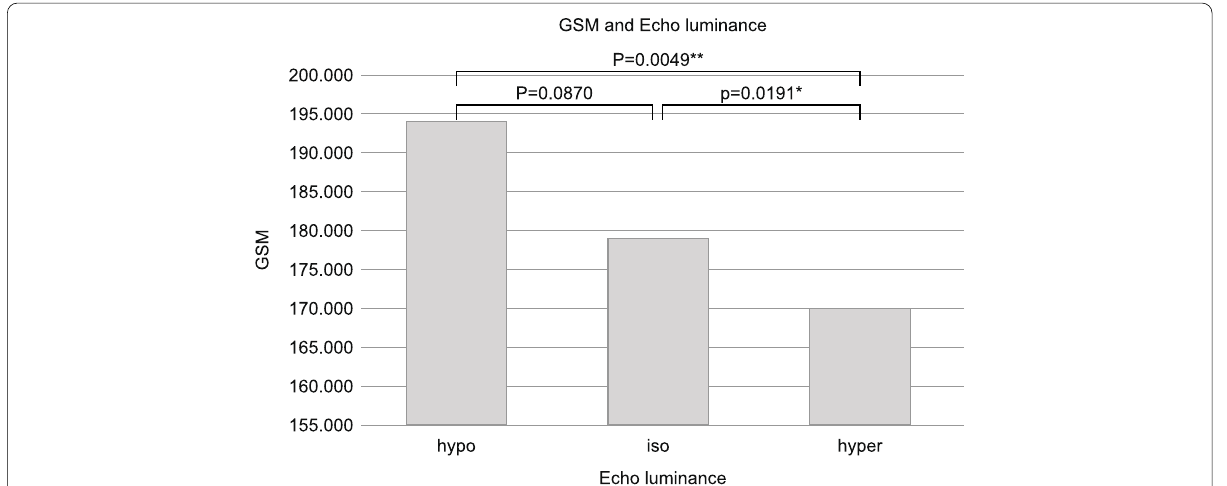
Fig. 7 Comparison of GSM and echo brightness (hypo, iso, hyper-echoic). The brightness of the narrowest region of the plaque was classified as hypo-echoic, iso-echoic, or hyper-echoic based on the brightness of the intima-media complex near the plaque